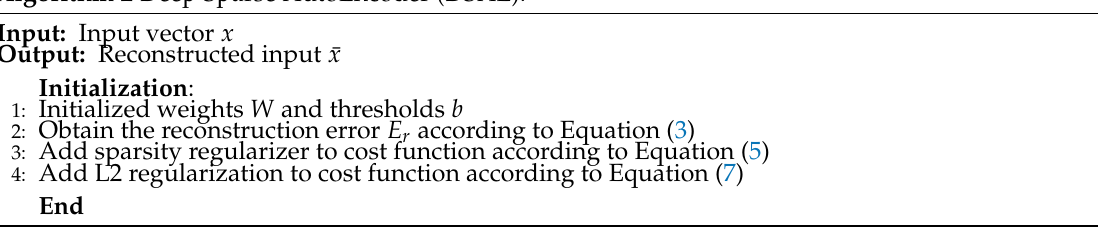
Algorithm 2 Deep Sparse AutoEncoder